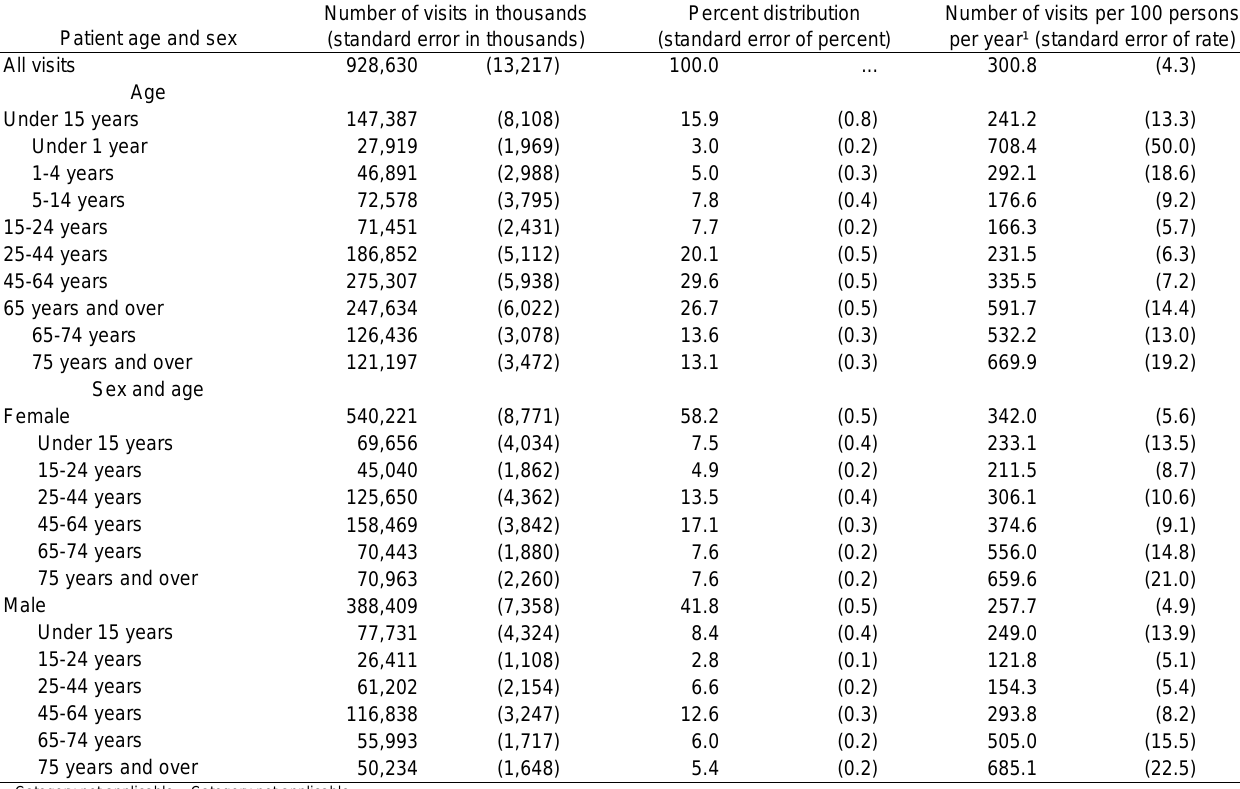
...Category not applicable. ¹Visit rates are based on the July 1, 2012 set of estimates of the civilian noninstitutional population of the United States as developed by the Population Division, U.S. Census Bureau. NOTE: Numbers may not add to totals because of rounding. SOURCE: CDC/NCHS, National Ambulatory Medical Care